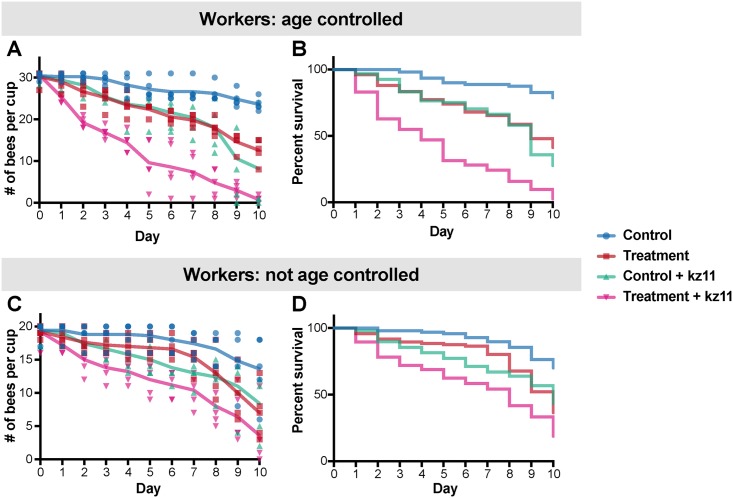
Survivorship of honeybees exposed to Serratia after tetracycline treatment.A) Number of control and tetracycline-treated honeybees (age-controlled) alive after exposure to Serratia kz11. Five replicates were performed for each group. Control bees were fed sterile sugar syrup for 5 d, and treatment bees were administered 450 ug/ml of tetracycline in sterile sugar syrup for 5 d, followed by exposure to i) Serratia kz11 or ii) sterile sugar syrup only. Survivorship was monitored and recorded each day for 10 d (S7 Data). B) The percent survival of age-controlled bees after Serratia exposure, shown as a Kaplan—Meier survival curve created using GraphPad Prism. Statistical analyses were performed using the coxph model implemented in the “survival” package [30] in R (S5 Data). C) Number of control and tetracycline-treated honeybees (non-age-controlled) alive after exposure to Serratia kz11. Five replicates were performed for each group. Survivorship was monitored and recorded each day for 10 d (S8 Data). D) Kaplan—Meier survival curve showing the percent survival of non-age-controlled bees after Serratia exposure. The survival curve was created using GraphPad Prism. Statistical analyses were performed using the coxph model implemented in the “survival” package [30] in R (S6 Data).